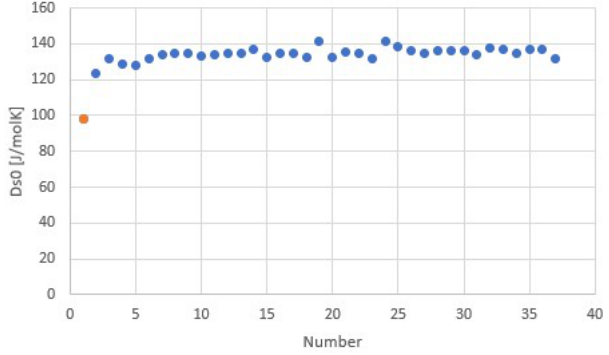
Figure 9. Transition entropy at 1 atm for ammoniate transitions of chloride salts, corresponding to Figures 7 and 8. The orange point is the transition entropy between ammonia vapor and liquid, which differs considerably from the average value for ammoniate transitions, as expected.